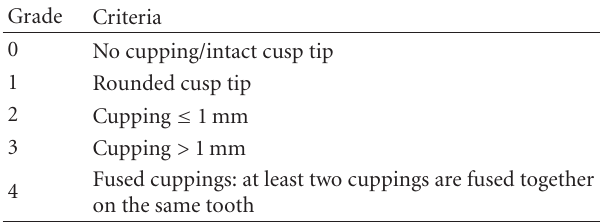
Table 3: Ordinal scale used for grading cuppings on occlusal surfaces of first permanent molars and primary molars